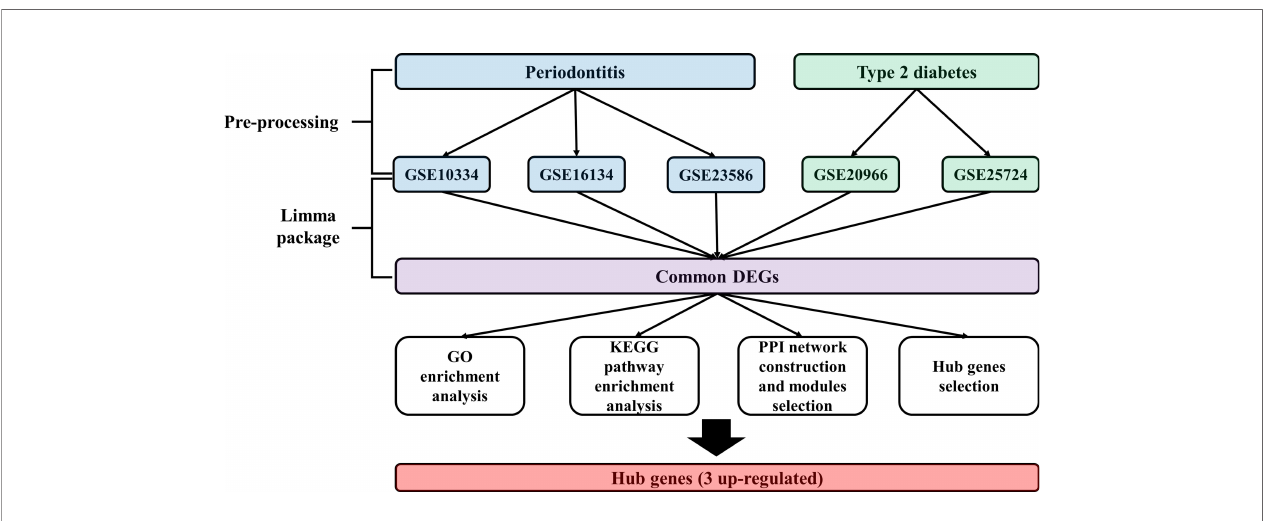
FIGURE 1 | Study fl ow